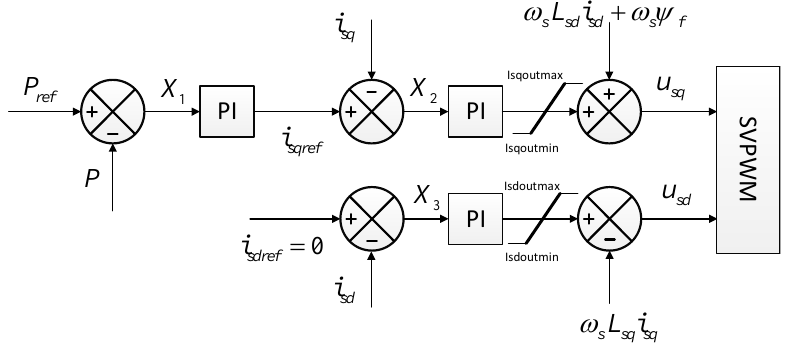
Figure 3. Control diagram for machine-side converter (MSC).